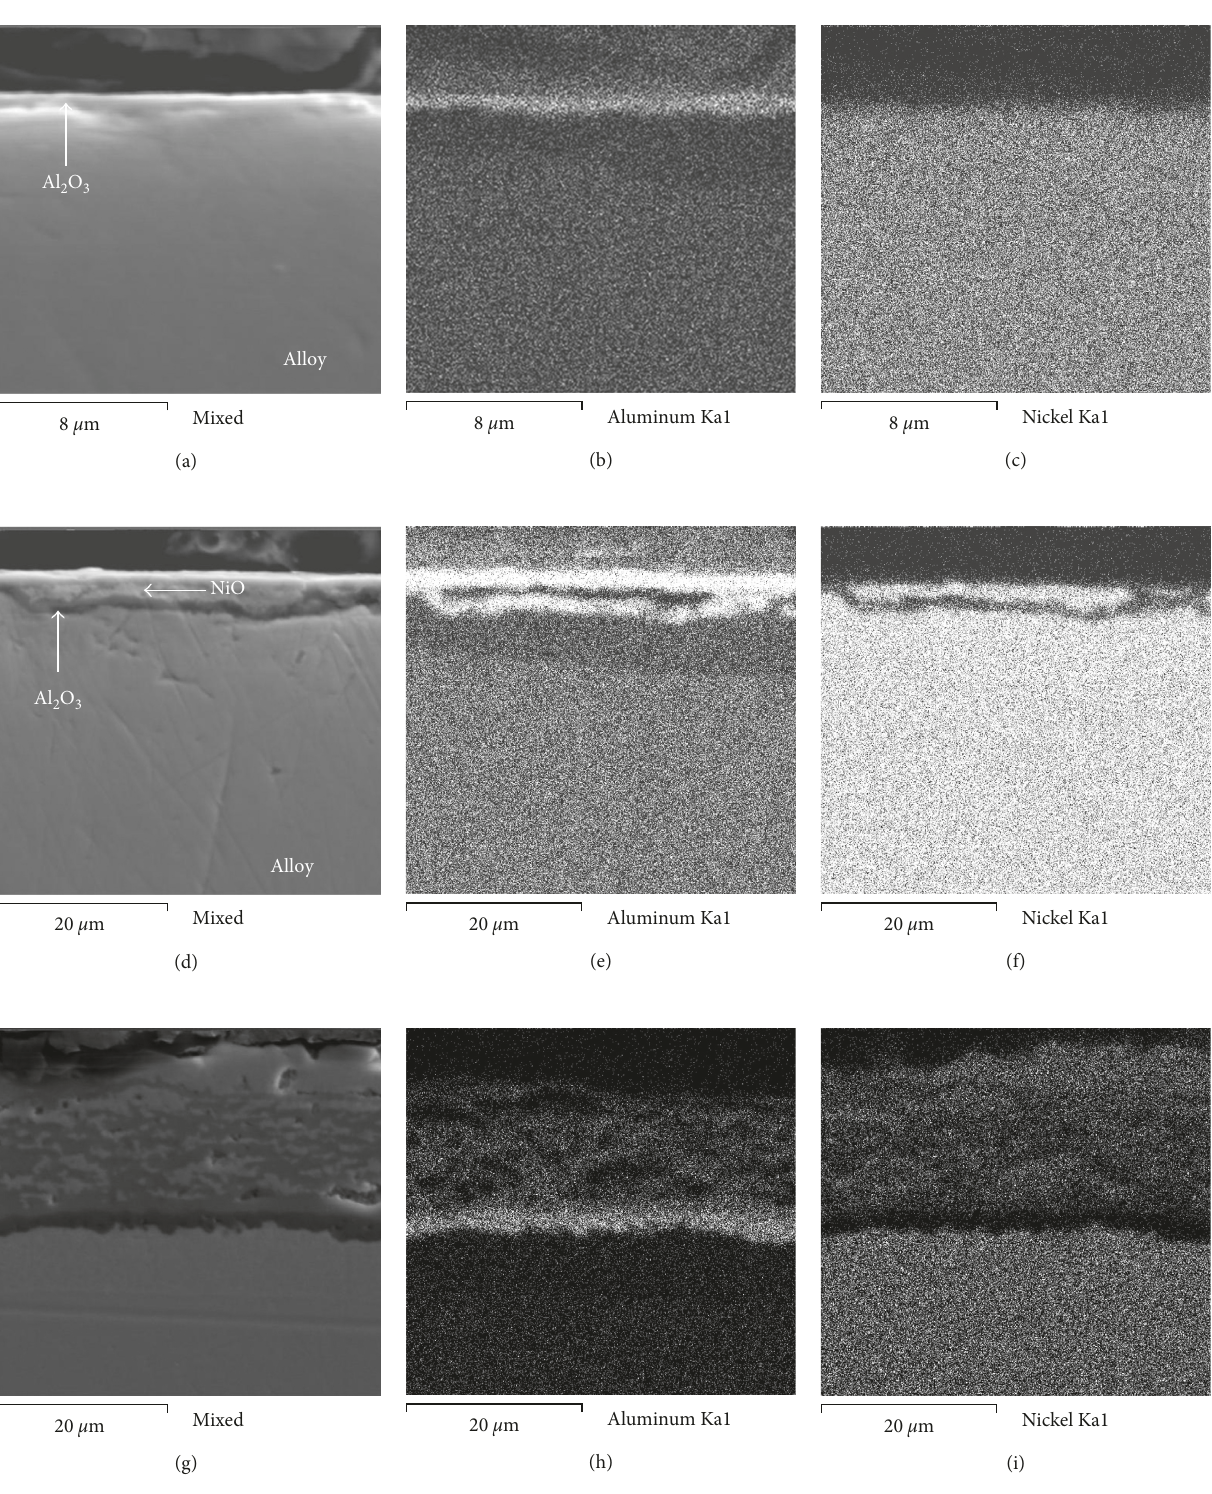
Figure 10: SEM micrograph and mapping elements: (a–c) Pd-doped alloy (900 ° C), (d–f) Pt-doped alloy (1000 ° C), and (g–i) Ag-doped alloy (1100 °